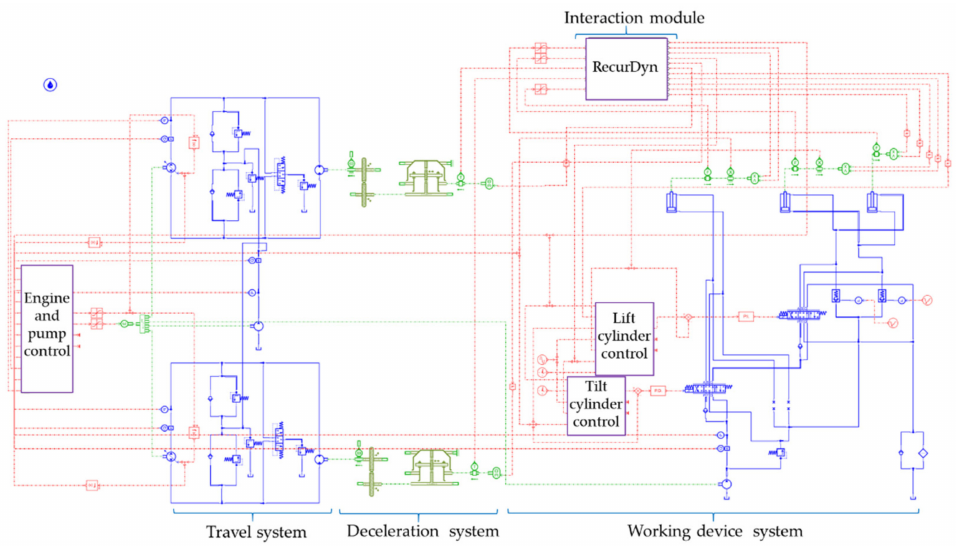
Figure 4. Control system